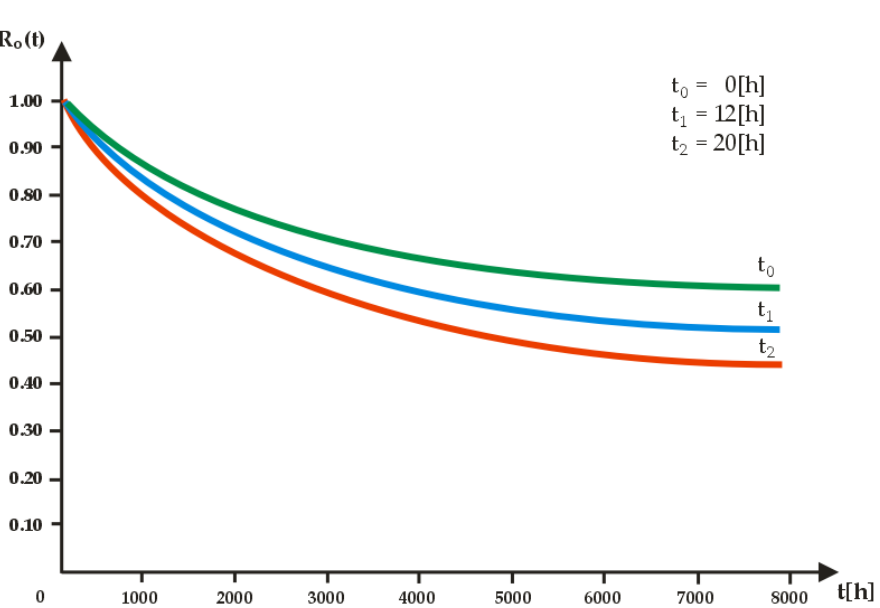
Figure 4. Graph of changes in the probability of the analyzed valued of WFD system remaining in the state of full fitness S 1 for a period of 1 year—own study.